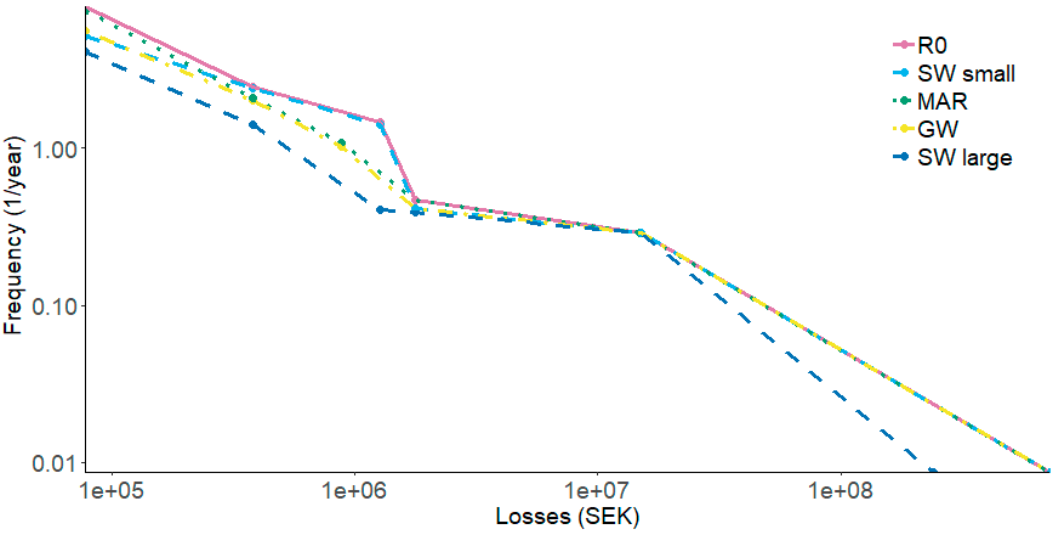
Figure 3. Risk curves for analyzed risk reduction measures over all scenarios (mean values). Note that the curves are plotted on log-log scale with cumulative frequencies.